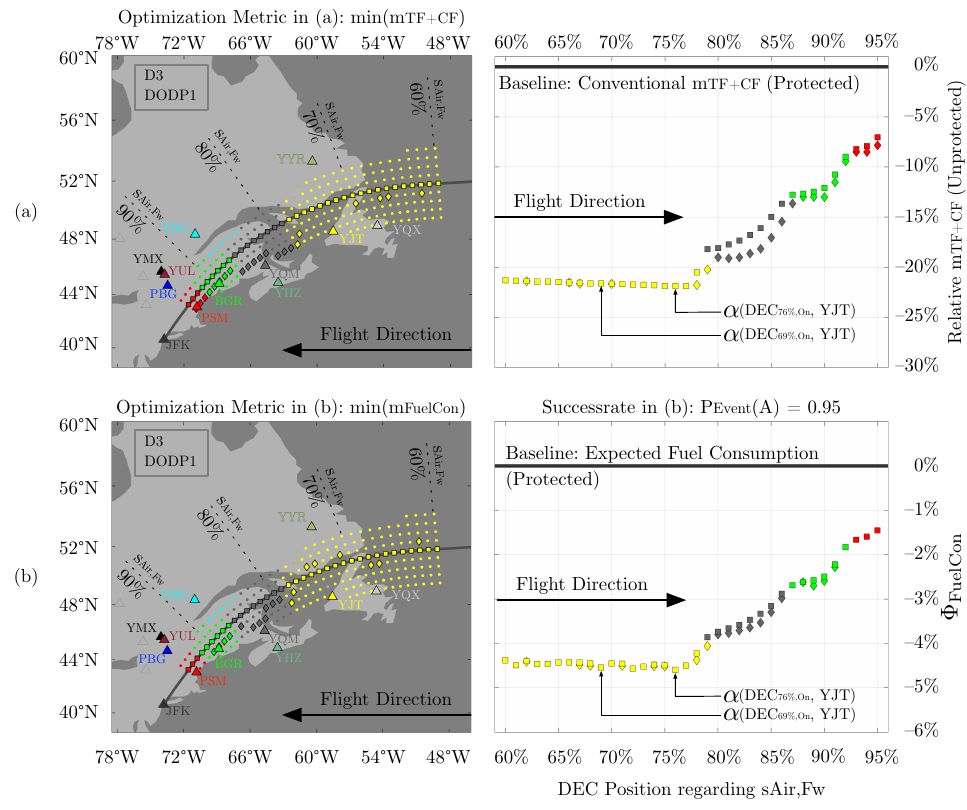
Figure 3. Overview on fuel planning scenarios with regard to ( a ) minimum fuel uplift, and ( b ) minimum fuel consumption for an assumed formation success probability of P Event ( A ) = 0.95. Appropriate aerodromes WP ERA are displayed as triangles, and the color code is used to assign decision points WP DEC to the corresponding optimal WP ERA . Squares represent WP DEC located on the reference track. Small circles represent WP DEC located offside the reference track. Diamonds represent WP DEC offside the reference track with a higher savings potential than the corresponding on-track WP DEC